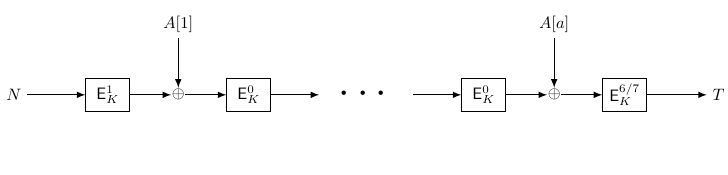
Figure 14: ESTATE with a AD blocks and empty